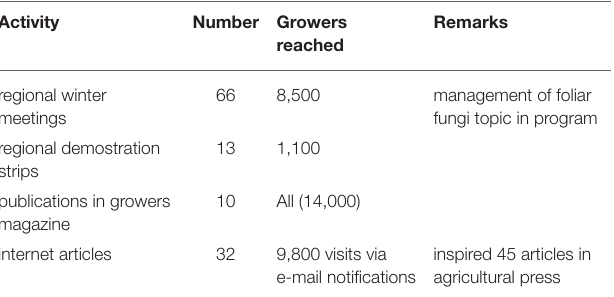
TABLE 5 | Results extension project “Integrated management of foliar fungi”